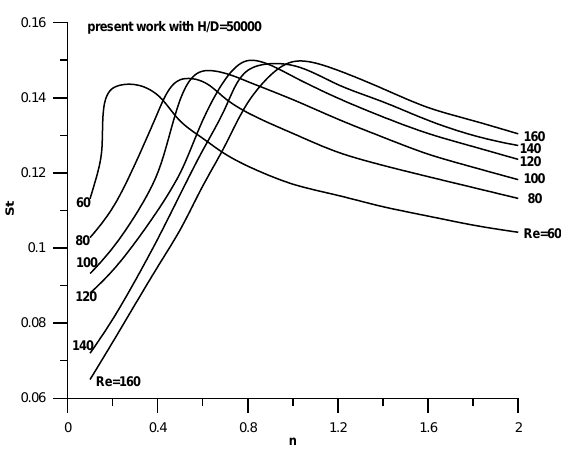
Figure 9. Values of the Strouhal number for different Reynolds numbers for shear-thinning and shear-thickening fluids in an unconfined field.